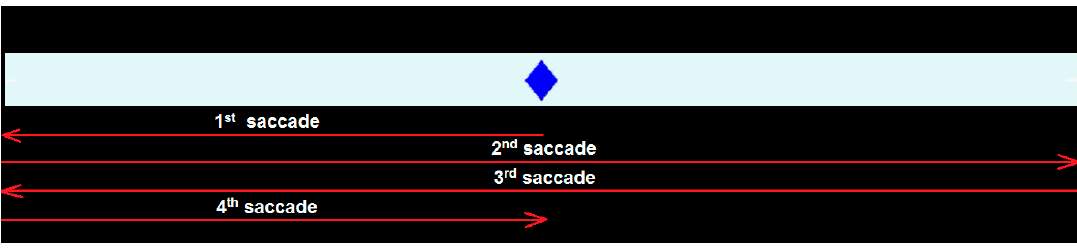
Figure 7. Representation of the stimulus movement and the associated saccadic eye movements.